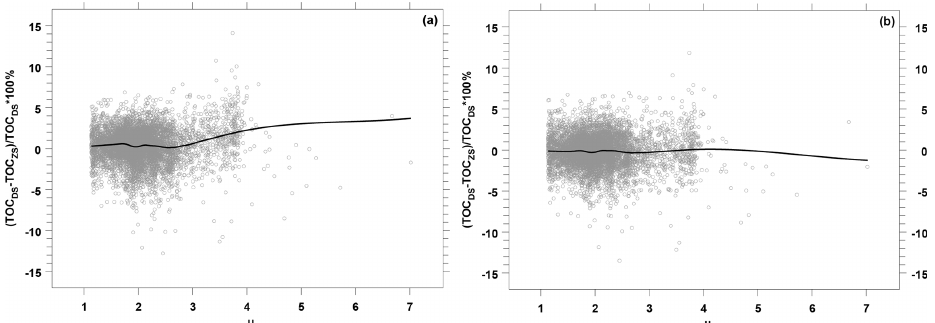
Figure 2. Air mass dependence of differences between daily mean TCO 3 values by DS and ZS measurements as a percentage of the DS TCO 3 values: original data (a) and ZS TCO 3 after the correction using Eq. (1) (b) .